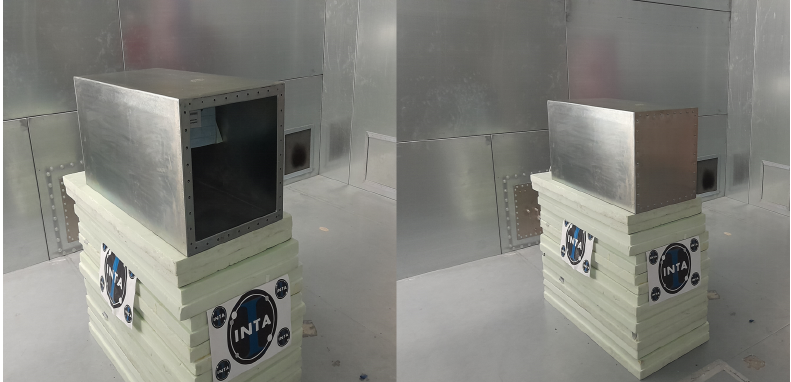
Figure 15. Nested RCs: reference configuration ( left ) and sample under test ( right ).